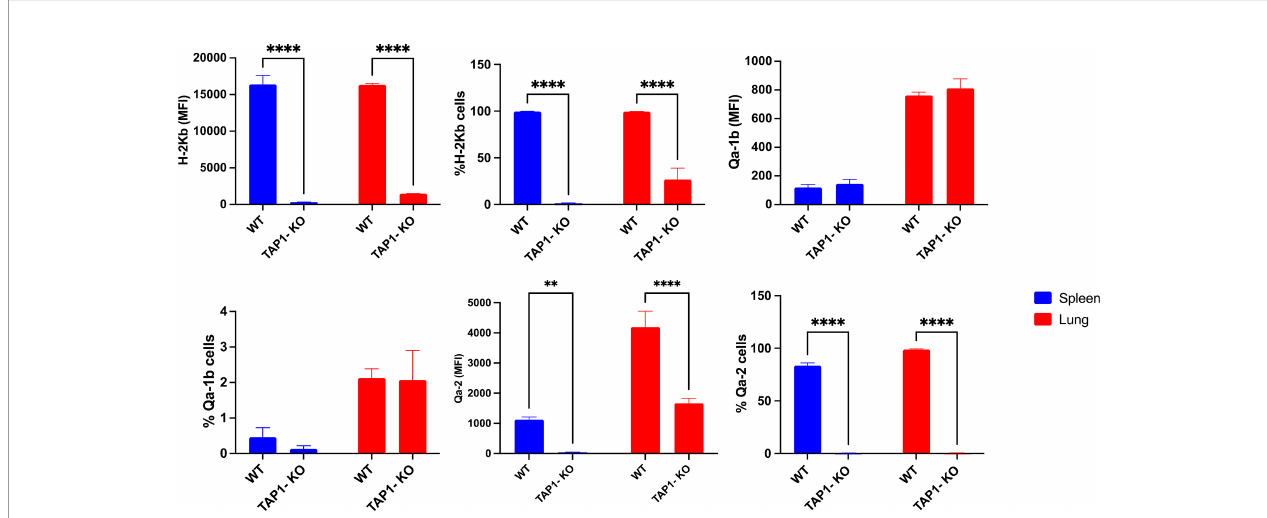
FIGURE 3 | Expression and frequency of NK cell subsets based on MHC class I molecules H-2K b , Qa-2 and Qa-1 b in B6 wildtype and TAP1-KO mice. The NK cells were derived from lung and spleen, and stained and acquired by fl ow cytometry without expansion ( ex vivo ). Statistical analysis was performed using GraphPad Prism 9.0.0 with an ordinary two-way ANOVA with Sidak multiple comparisons tests (n=3). **, p<0.01 and ****,